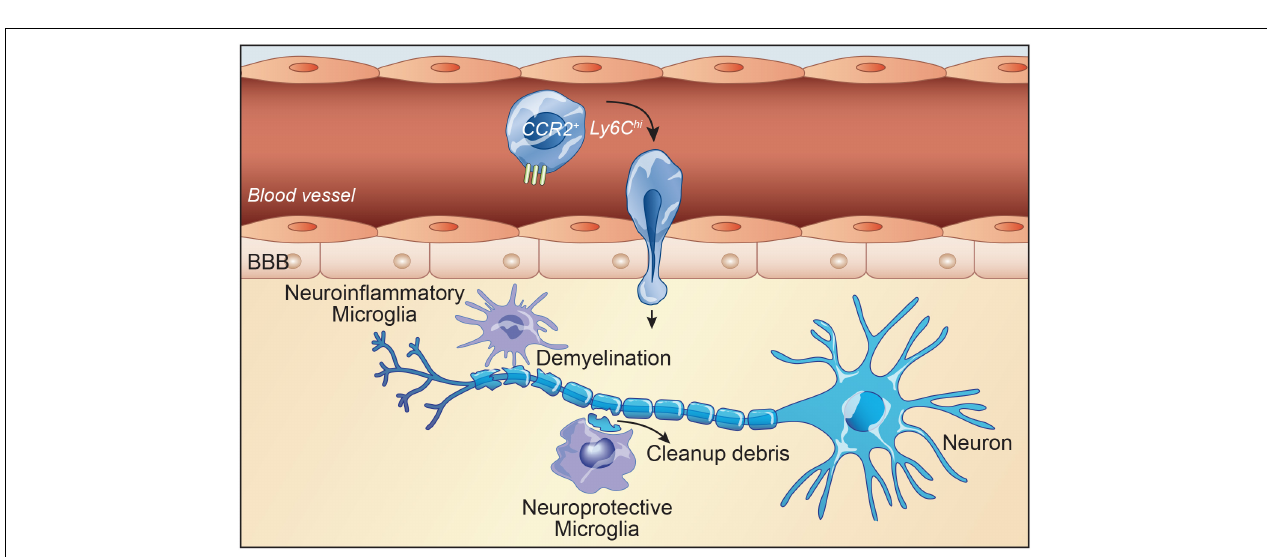
FIGURE 2 | Inflammatory monocytes play central role in disease progression in experimental autoimmune encephalomyelitis (EAE). In the early stages of EAE, myeloid cells, mainly monocytes, infiltrate the CNS and contribute to the inflammatory response and pathology. Chemokine receptor CCR2 is critical for the accumulation of Ly6C high /CCR2 high monocytes in the CNS. CCR2 and its ligand CCL2 play an important role in regulating Ly6C high /CCR2 + monocyte infiltration to the CNS and facilitate tissue damage in multiple sclerosis (MS) and EAE. On the contrary, inhibition of monocyte recruitment delays the disease. Microglia and macrophages accumulate in active sites of demyelination and neurodegeneration in MS. The majority of cells associated with active demyelination originate from resident microglia. Reactive microglia are present at early and late stages of disease. They are present in demyelinating lesions. Microglial activation even occurs before the onset of EAE. Once microglia are activated, they can damage other CNS cells, in particular oligodendrocytes and neurons. Microglia activation induces massive immune cell infiltration and demyelination which is followed by remyelination. However, microglia have been shown to exhibit both neuroinflammatory as well as neuroprotective